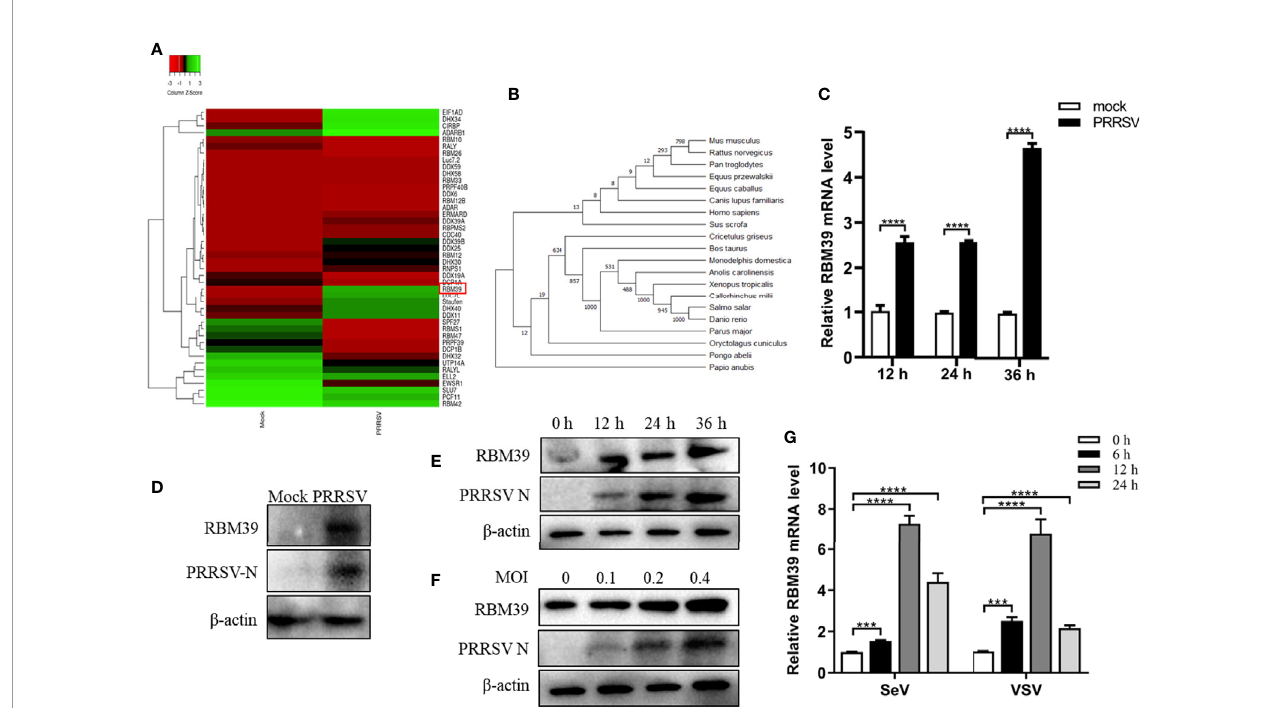
FIGURE 1 | Upregulation of RBM39 in 3D4/21 cells by PRRSV infection. (A) Heat map of RNA binding protein differentially expressed genes made using online websites (http://www.heatmapper.ca/). (B) RBM39 evolutionary tree among different species. (C – E) 3D4/21 cells were subjected to mock infection or infected with 0.4 multiplicity of infection (MOI) PRRSV. (C) Cells were collected at the three time points (12, 24, 36 h) and subjected to real-time RT-PCR to analyze the expression level of RBM39. (D) Cell lysates were collected at 24 h post-infection and subjected to Western blot analysis with antibody to RBM39 to analyze the protein expression. (E) The cells were collected at 0 h, 12 h, 24 h and 36 h post-infection; (F) The cells were infected with 0, 0.1, 0.2 and 0.4 MOI PRRSV respectively and were collected at 24 h post-infection, the RBM39 protein level was analyzed by WB. (G) 3D4/21 cells were infected with SeV and VSV. The cells were collected at 0, 6, 12, and 24 h post-infection, and the RBM39 mRNA level was analyzed by qRT-PCR. Data are representative of results from three independent experiments. The statistically signi fi cant at P-value was demonstrated in Statistical Analysis